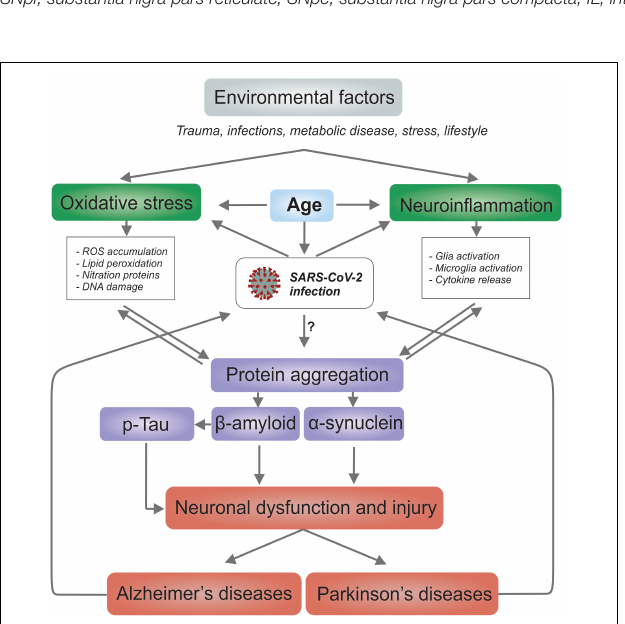
FIGURE 3 | SARS-CoV-2 infection and possible links for both Alzheimer’s and Parkinson’s disease. The common risk factors between COVID-19 and neurodegenerative diseases is the age; the oxidative stress; and, neuroinflammation. It’s possible that COVID-19 patients are more susceptible to developing neurodegenerative diseases and that patients with neurodegenerative diseases are more susceptible to contracting